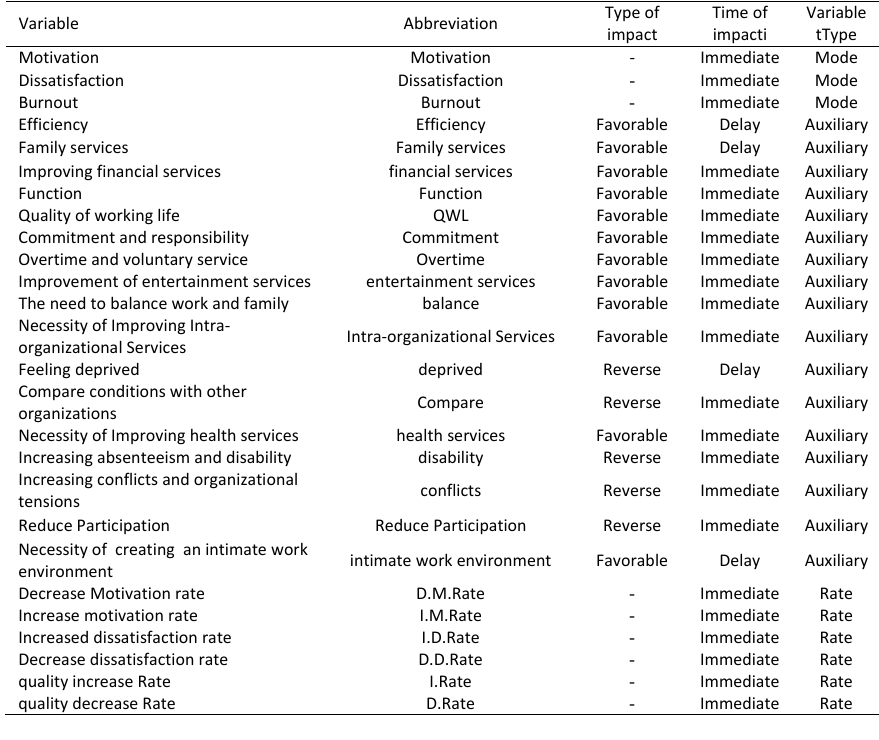
Table 2: Table of type and specifications of variables Table 2. Table of type and specifications of variables